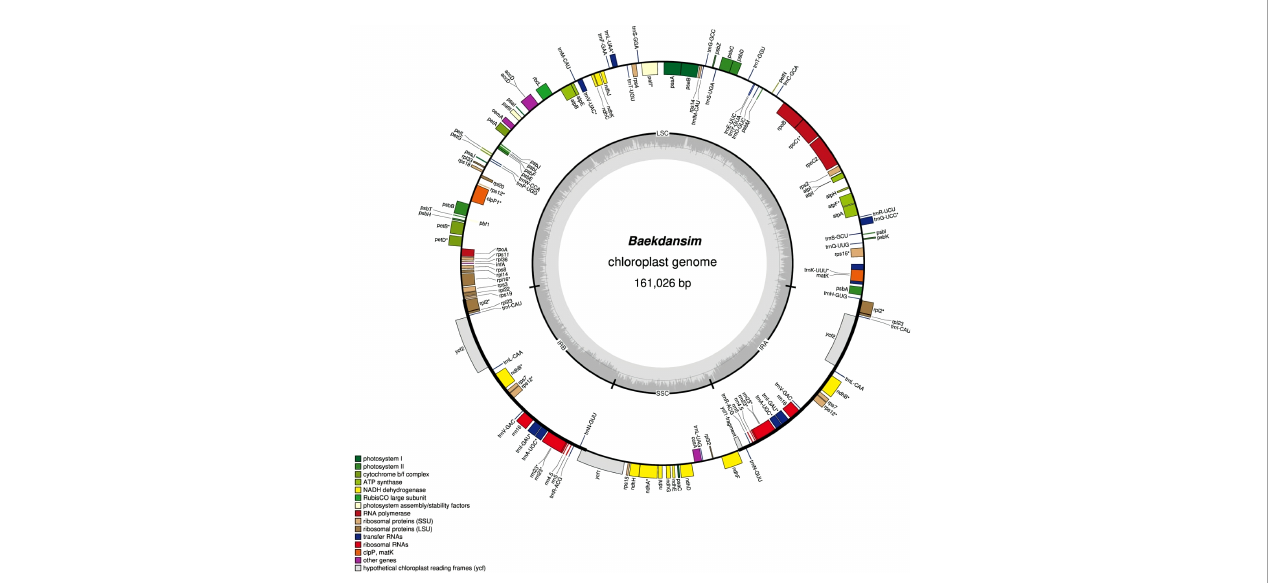
FIGURE 1 Circular chloroplast genome map of H. syriacus var. Baekdansim . The inner grey circle indicates the proportion of GC in each region. The genes illustrated in the inner circle are transcribed clockwise. Genes corresponding to distinct functional groups are denoted using distinct